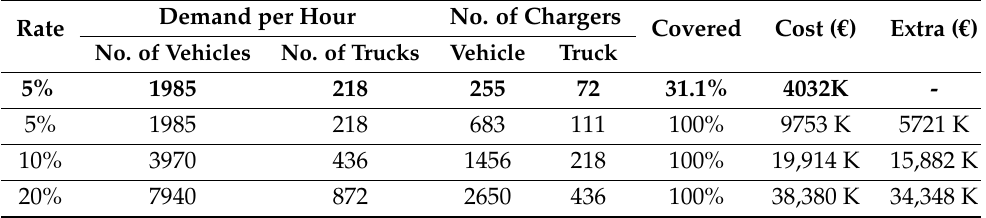
Table 7. Cost and demand coverage with different EV rates .